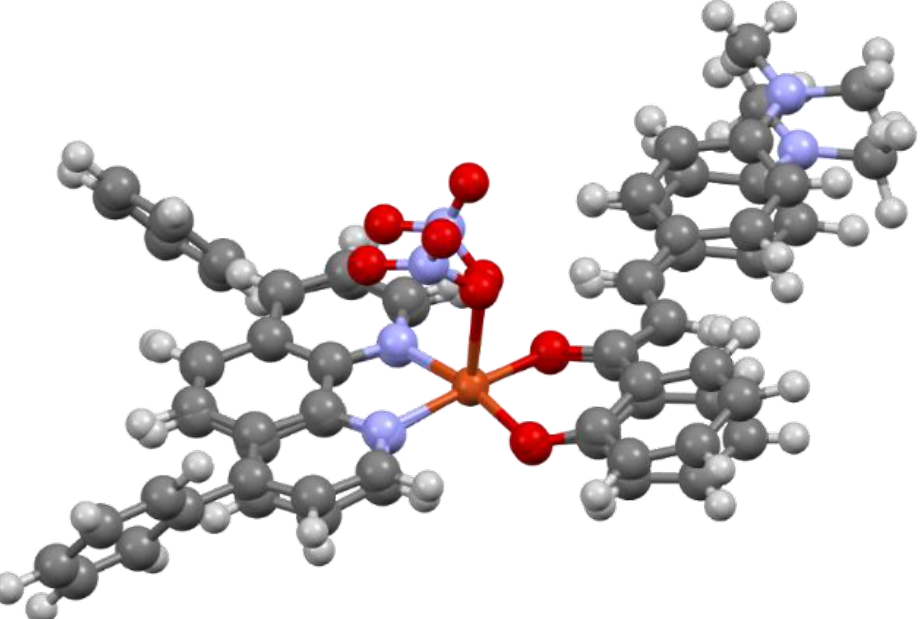
Figure 3. An overlay of the DFT optimized geometries of [Cu(bphen)(L)(NO 3 )] ( 2 ) (in the water